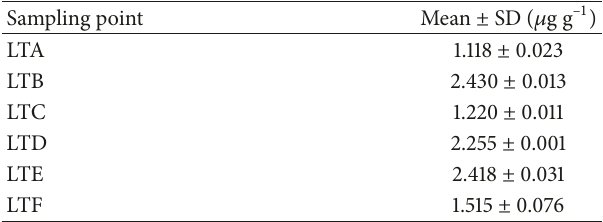
Table 2: Mean FA concentration and standard deviation (SD) of local fish Oreochromis niloticus (tilapia) sampled from retail and wholesale cold stores.